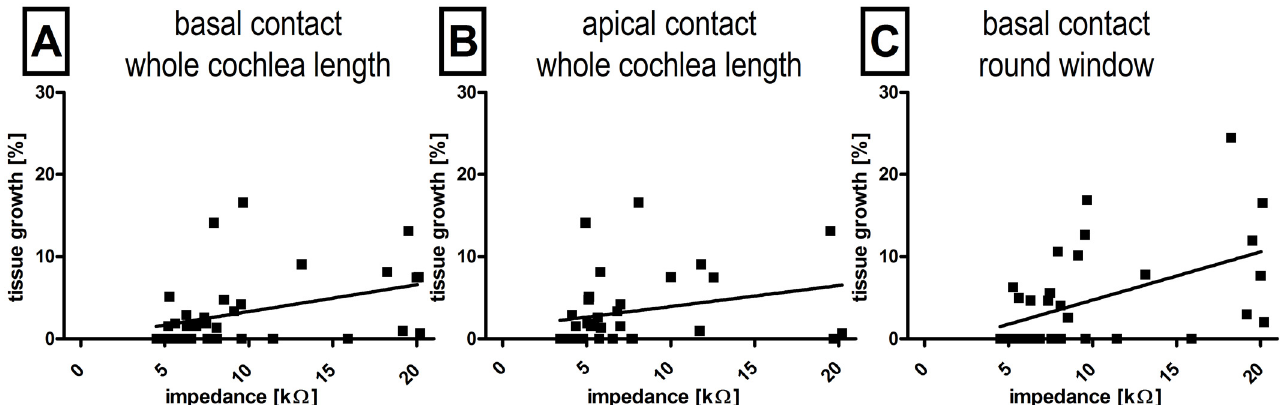
Fig 12. Correlation between tissue growth and impedance. Tissue growth around the electrode array significantly correlated with the measured impedance on the basal electrode (A) as well as on the more apical electrode (B). The highest correlation was found when the tissue growth at the round window was compared to the impedance measured on the basal contact